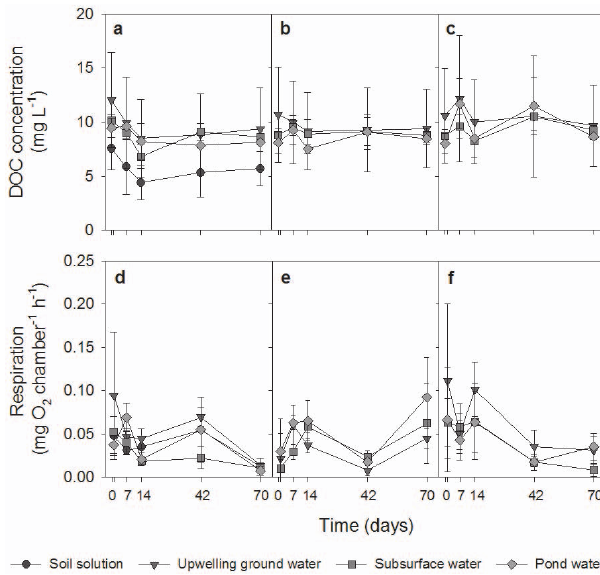
Fig. 6. Dynamics of (a) , (b) , (c) DOC concentrations and (d) , (e) , (f) microbial respiration during 70 days of incubation of four water types from the Chicken Creek Catchment inoculated with microbial communities from (a) , (d) soil; (b) , (e) stream sediment; and (c) , (f) pond water. Microbial respiration data are the sum of oxygen consumption per hour in one respiration chamber containing 47mL suspensions and 11.9cm 2 of biofilm. Symbols and error bars indi- cate means ± 1SD, n = 3. For statistical analyses see Table